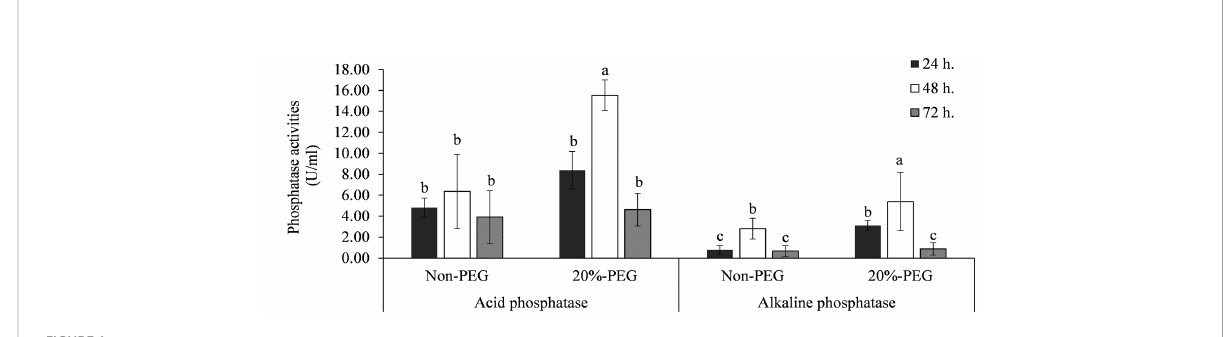
FIGURE 1 Enzyme activities of acid and alkaline phosphatases produced by KKUT8-1 in the cultures containing 0 and 20% of PEG during 72 h of incubation. Different letters indicate signi fi cant differences at P <0.05 by